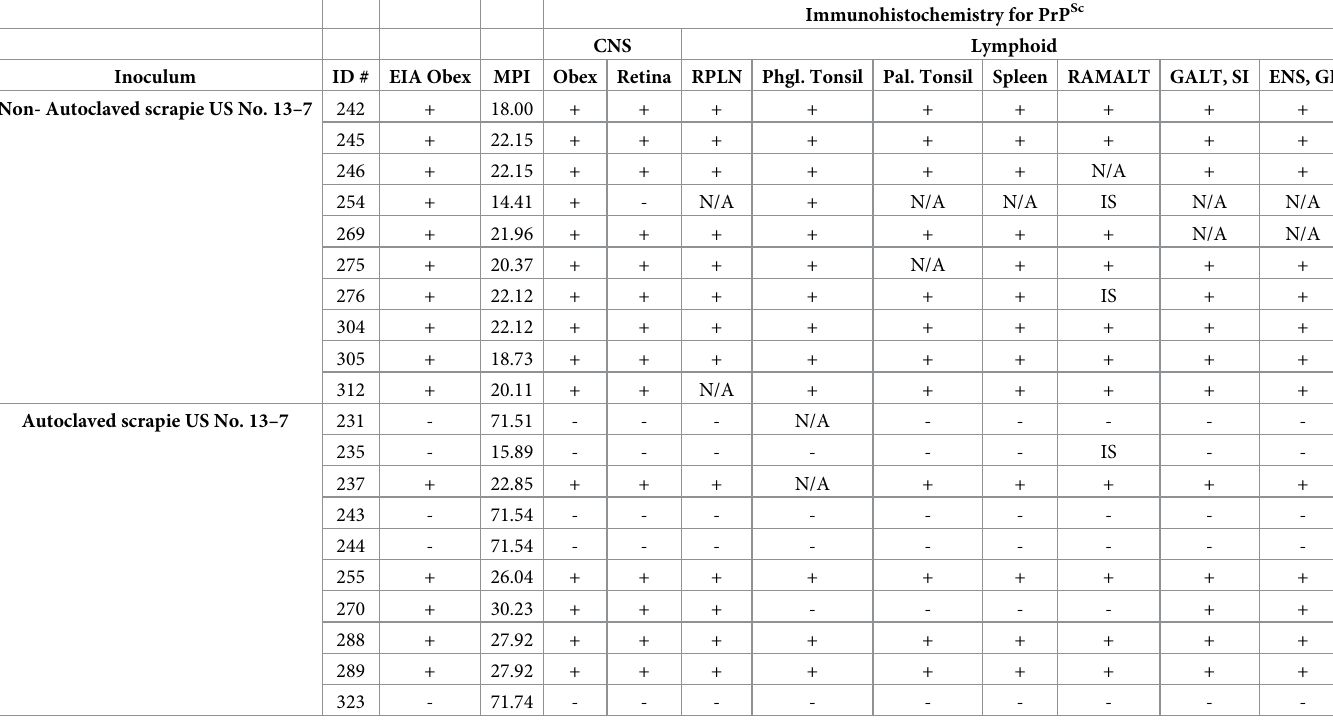
Table 1. Immunohistochemistry of CNS and non-CNS tissues.